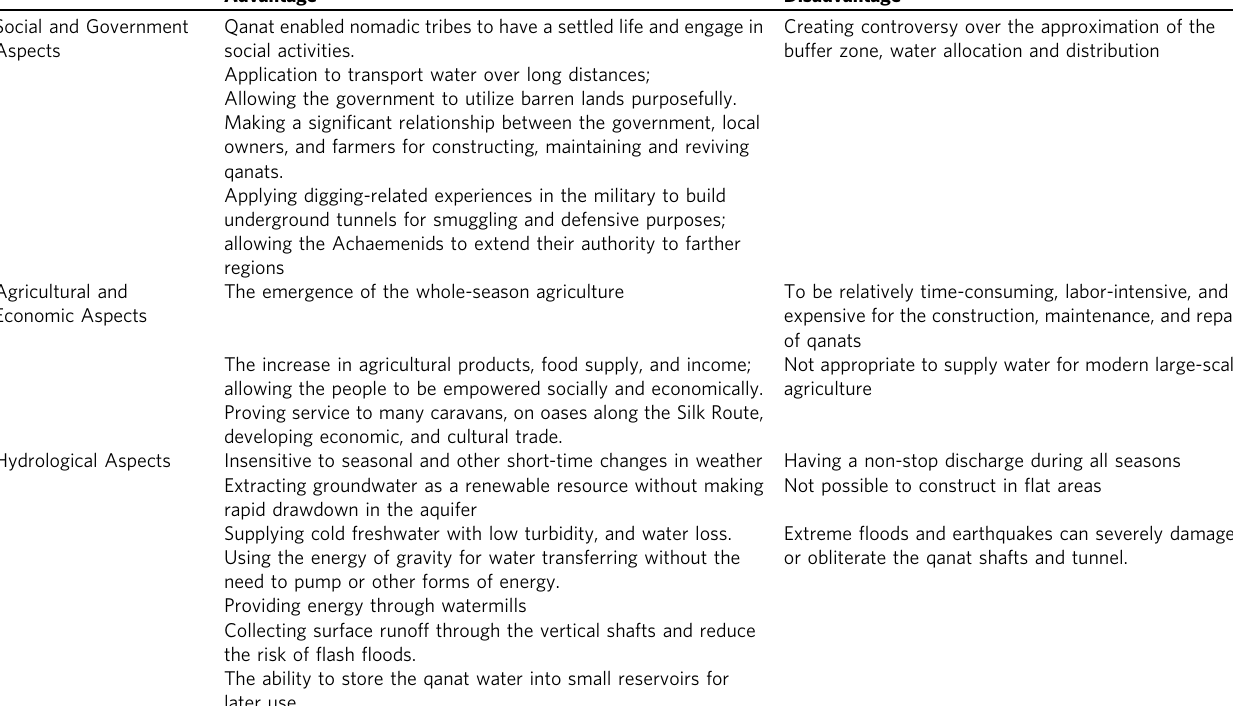
Table 1 Advantages and disadvantages of the qanat